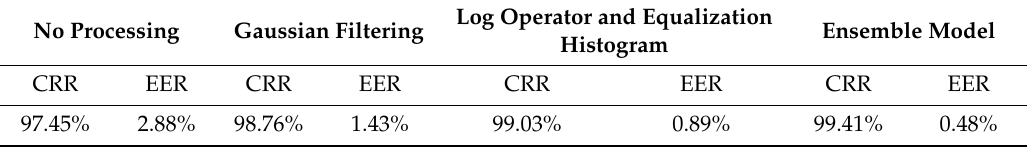
Table 2. The CRR and EER in image processing layer experiment.